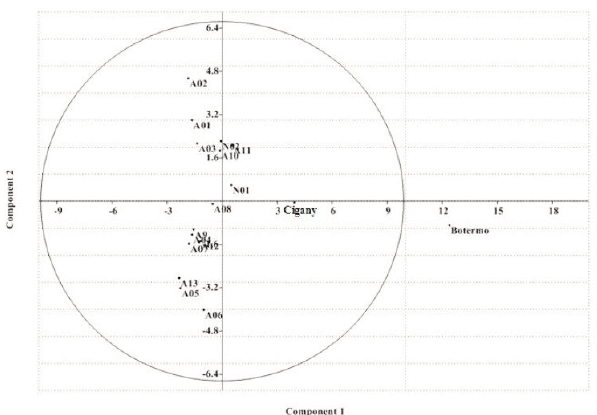
Fig. 2 - Factor scores for the first two principle components (PCs) for Sour cherry